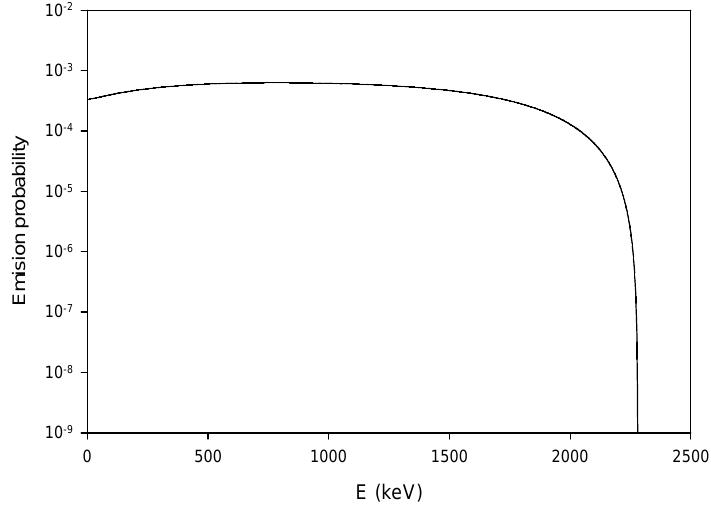
Figure 1. Spectrum of β - radiation emitted by 90